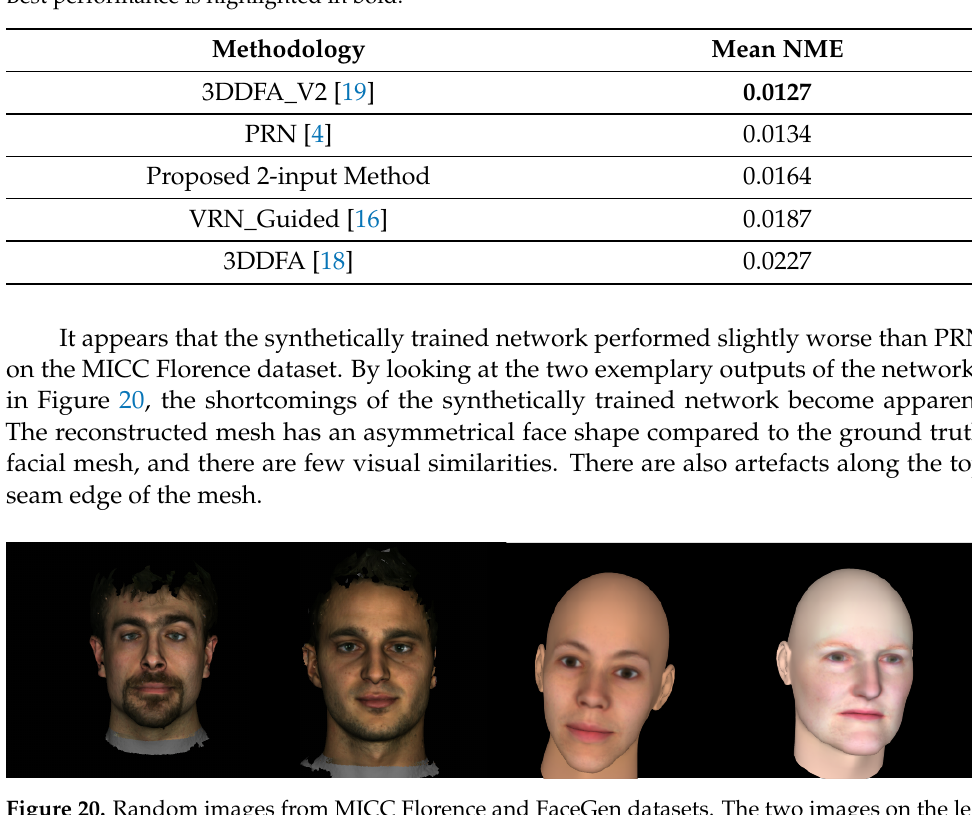
Table 2. The NME of our proposed, synthetically trained, 2-input network against state-of-the-art. Best performance is highlighted in bold.